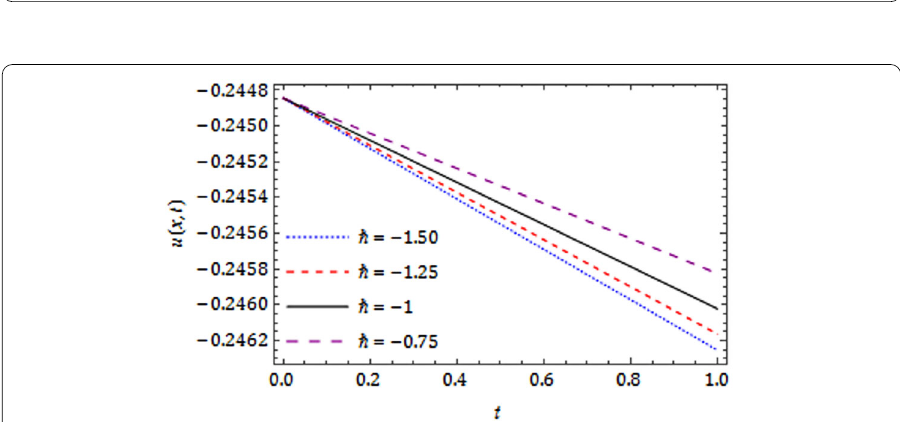
Figure 5 Plot of u ( x , t ) with diverse (cid:2) when ω = 0.005, (cid:13) = 0.1, c = 10, n = 5, α = 1 and x = 1 for Example 6.1